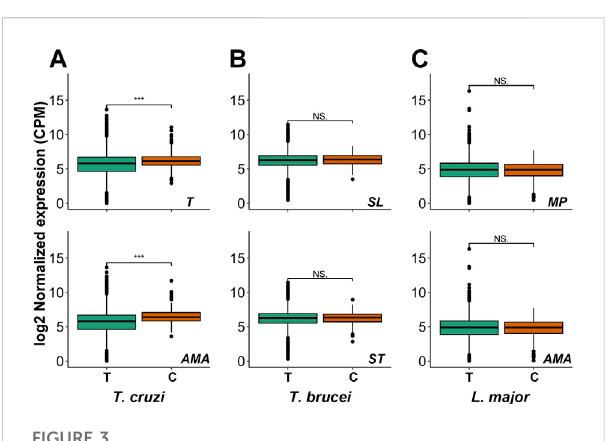
FIGURE 3 Candidate genes expression in life cycle stages. Box plots showing the mRNA levels of the total genes (T) and of our drug target candidates (C) in (A) T. Cruzi trypomastigotes (T) and amastigotes (AMA) (B) Trypanosoma brucei slender (SL) and stumpy (ST) forms of blood trypomastigotes and (C) Leishmania major metacyclic promastigotes (MP) and amastigotes (AMA). Mann – Whitney – Wilcoxon test was performed to compare the different gene sets [ p -value < 0.001 (***); p -value < 0.05 (*); no signi fi cance (NS.)]. Only expressed genes are plotted (see Materials and